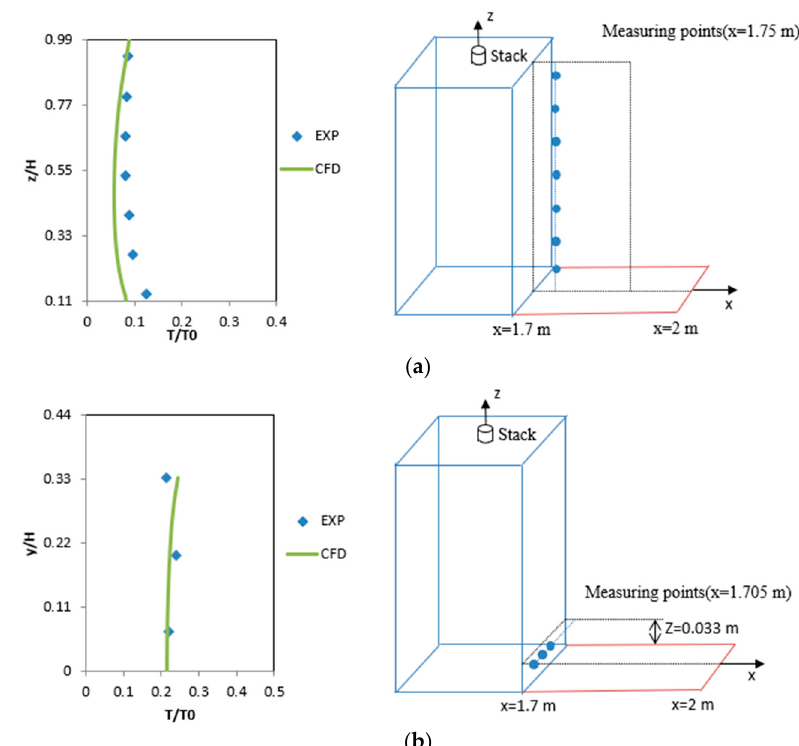
Figure 6. Velocity measuring points on the y = 0 m plane.